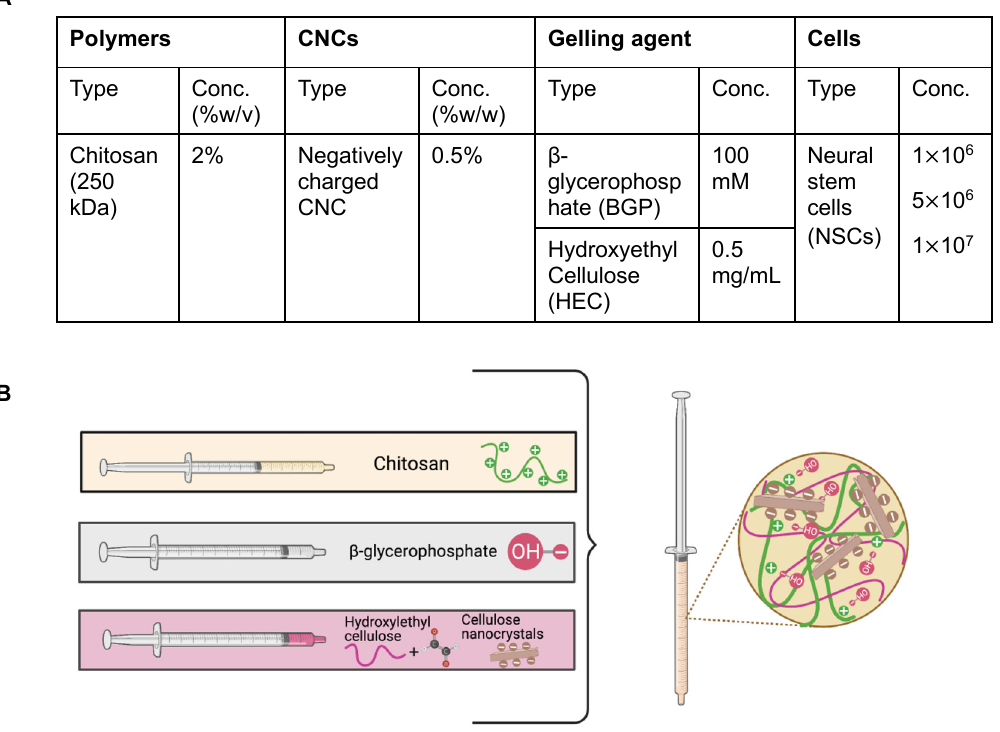
Figure 2. Optimized hydrogel formulations used in this study. ( A ) Table representing components of hydrogel formulations. ( B ) Schematic illustration of polymer interactions within hydrogel matrix.